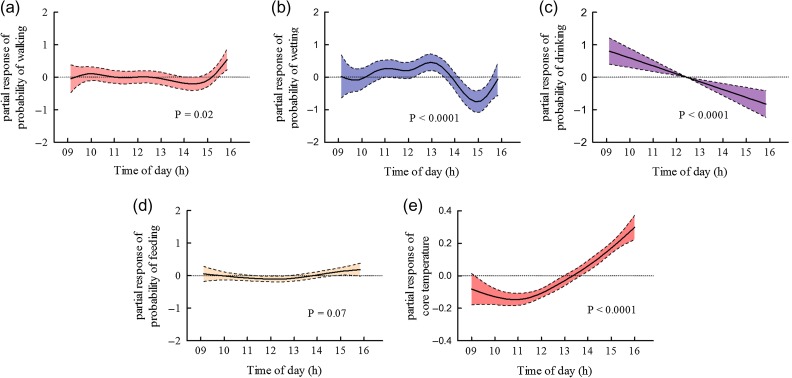
Outcomes of generalized additive mixed model analysis for recorded behaviours (a–d) and core temperature (e) dependent on time of day in selected best approximate models. Shaded areas and dashed lines represent 95% confidence intervals.